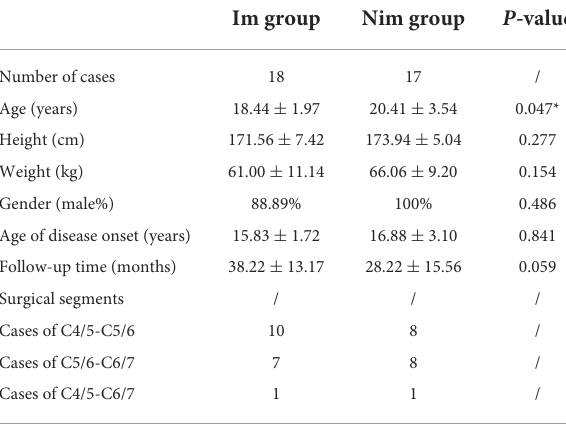
TABLE 2 Comparison of Q-DASH scores between the two groups of